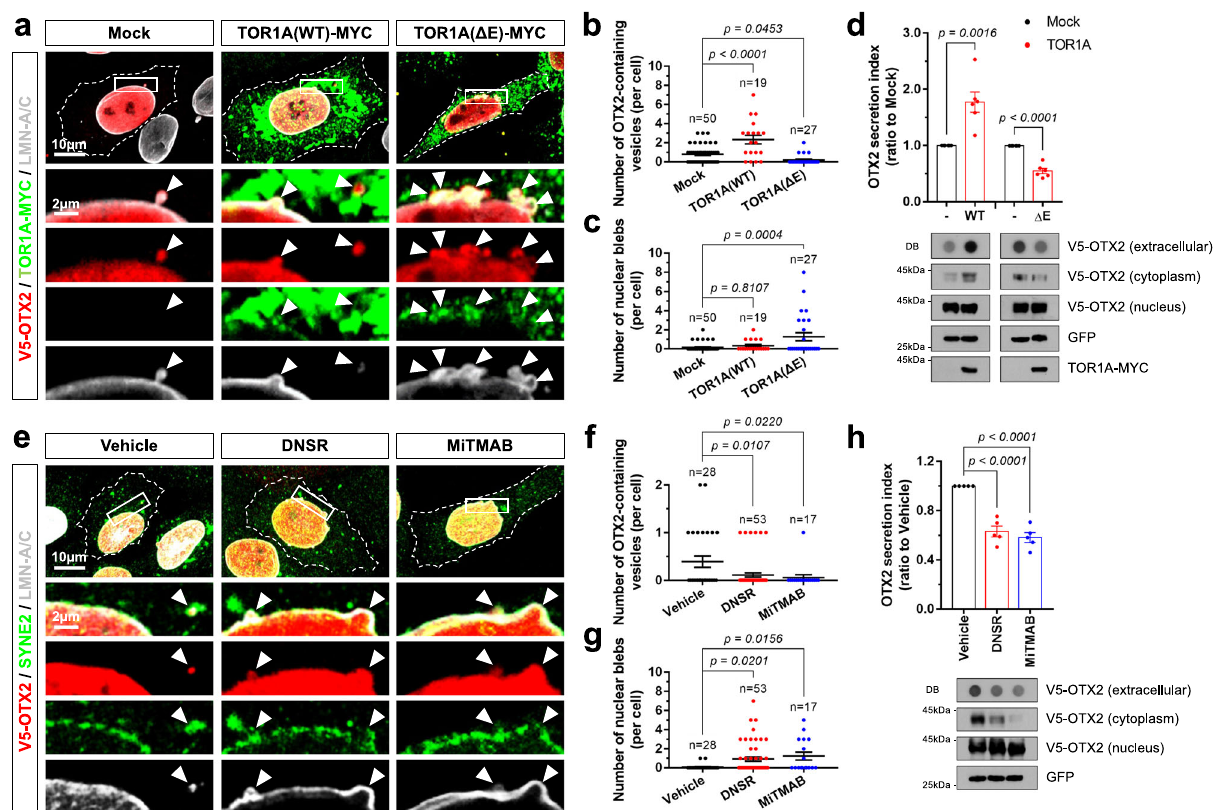
Fig. 4 | OTX2 is transported to the cytoplasm in nuclear budding vesicles. a HeLa cells co-expressing V5-OTX2 and MYC-tagged human TOR1A(WT) or TOR1A Δ E were stained with anti-V5 and anti-MYC antibodies. Nuclear laminae of the cellswerealsovisualizedbyimmunostainingofLMN-A/C.Arrowheadsindicate perinuclear and cytoplasmic V5-OTX2 signals, which are surrounded by signals of TOR1AandLMN-A/C.DotsinthegraphsrepresentthenumberofOTX2-containing vesicles( b )andnuclearblebs( c )inacell,respectively.Longsidebarsindicatemean values and error bars denote SEM obtained from 4 independent experiments. The numbers of cells analyzed are shown in the graphs. d V5-OTX2 in the growth medium and whole cell lysates of HeLa cells expressing TOR1A(WT)-MYC or TOR1A Δ E-MYC was detected by DB and WB, respectively. The cell lysates were fractionatedintothenucleusandcytoplasmpriortoWBdetection.Thecolumnsin the graph represent the relative secretion index of OTX2 determined by DB. The values are means and error bars denote with SEM obtained from 6 independent experiments. e Chemical inhibitors of DNM, such as DNSR (50 μ M) and MiTMAB